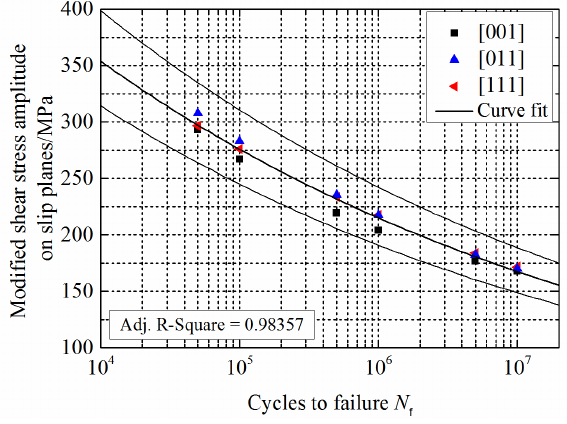
Figure 5. Fatigue life prediction for DD6 material at 800 °C by the proposed model.